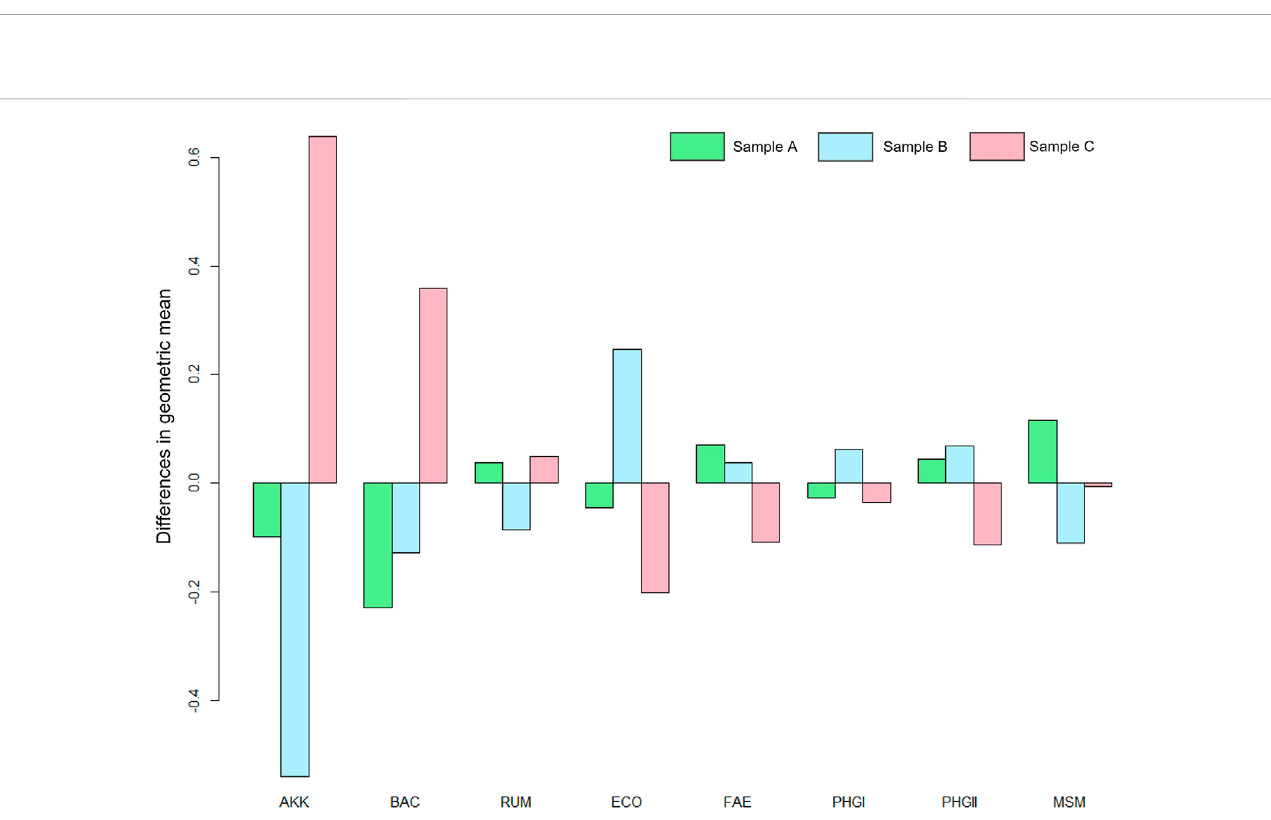
FIGURE 3 MANOVAplotwheretheeffectsofthesurgeryonthemarkersareobserved. A.muciniphila (AKK),Bacteroidetes(BAC), Ruminococcus spp.(RUM), E.coli (ECO), F. prausnitzii (FAE), F. prausnitzii phylogroup I (PHGI), F. prausnitzii phylogroup II (PHGII), M. smithii (MSM) and for sample A (before surgery), sample B (3 months after surgery) and sample C (6 months after